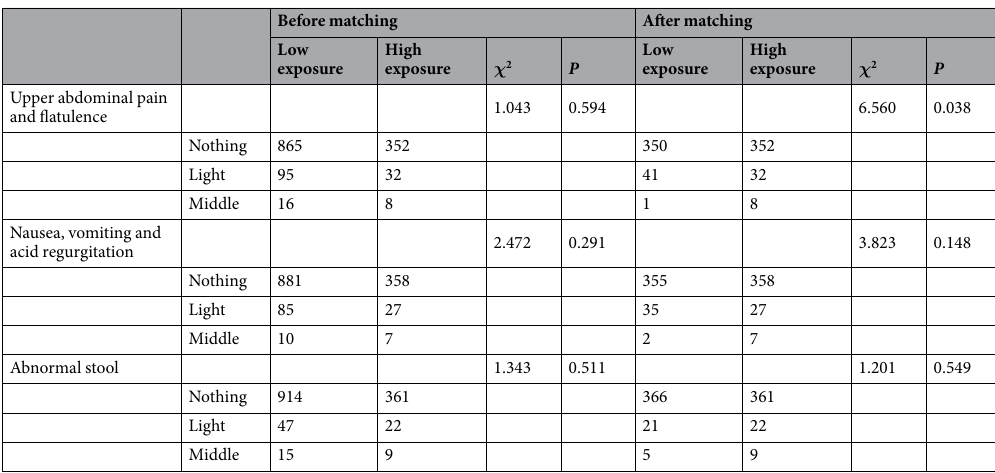
Table 8. Difference Test of Symptom Frequency in Digestive system before and after